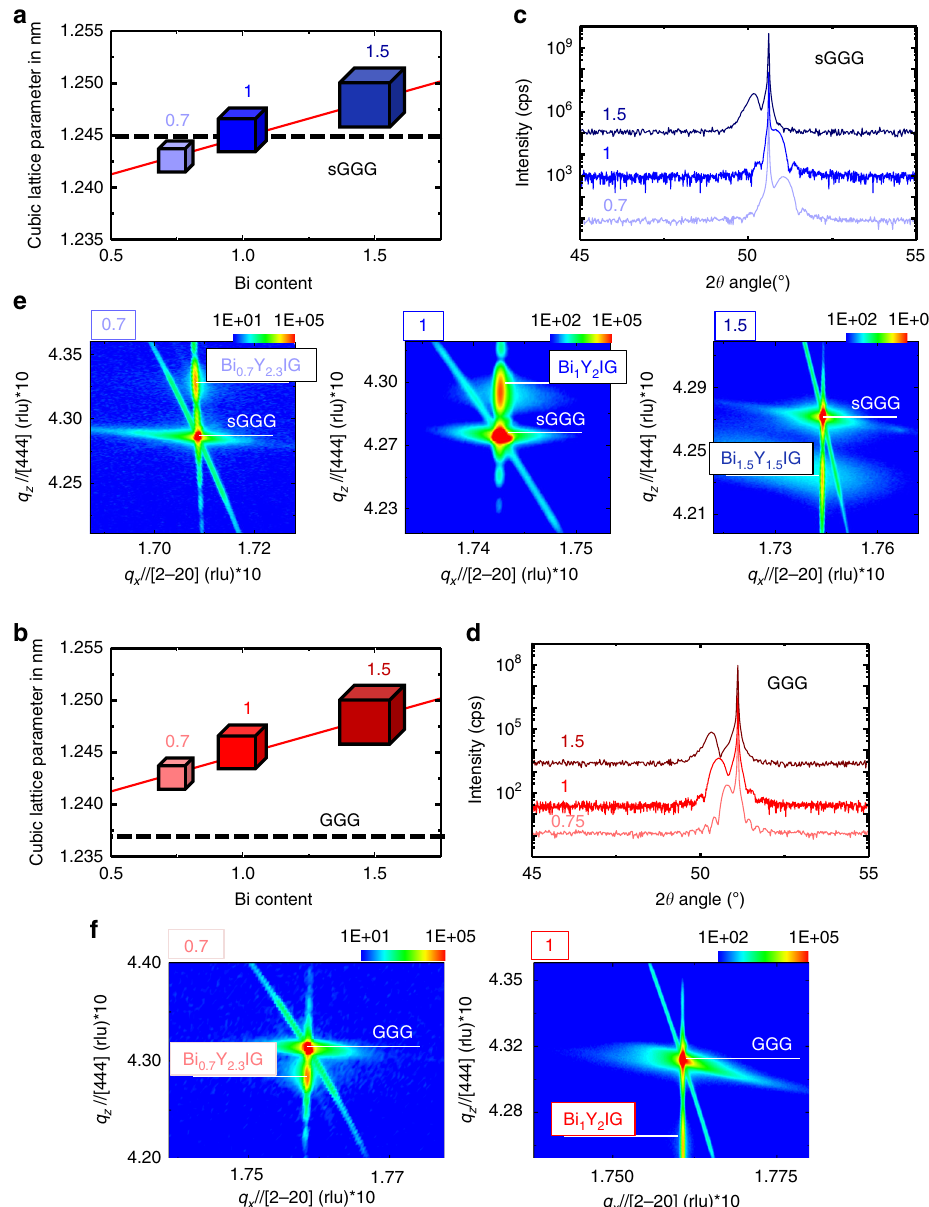
Fig. 1 Structural properties of ultra-thin BiYIG fi lms. a and b Evolution of the target cubic lattice parameter of Bi x Y 3- x IG, the dashed line represents the substrate (sGGG and GGG, respectively) lattice parameter and allows to infer the expected tensile or compressive strain arising for each substrate/target combination. c and d 2 θ – ω X-Ray diffraction scan along the (111) out-of-plane direction for Bi x Y 3- x IG fi lms grown on sGGG (111) and GGG (111), respectively. From the fi lm and substrate diffraction peak position, we can conclude about the nature of the strain. Compressive strain is observed for 1.5 doped fi lms grown on sGGG substrate and for all fi lms grown on GGG whereas tensile strain occurs for fi lms with x = 0.7 and x = 1 Bi content grown on sGGG. e and f RSM along the evidence the (642) oblique plan showing pseudomorphic growth in fi lms: both substrate and fi lm the diffraction peak are aligned along the q fi lm (up or down) along q fi t between the x is related to the out-of-plane mis x //[20-2] direction. The relative position of the diffraction peak of the substrate and the fi lm (tensile or